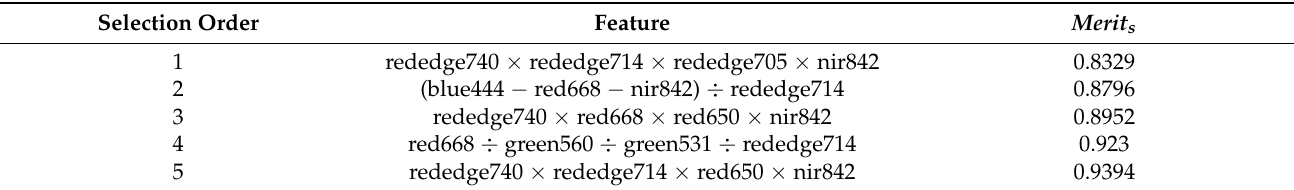
Table 4. Bands combinations selected by CFS .